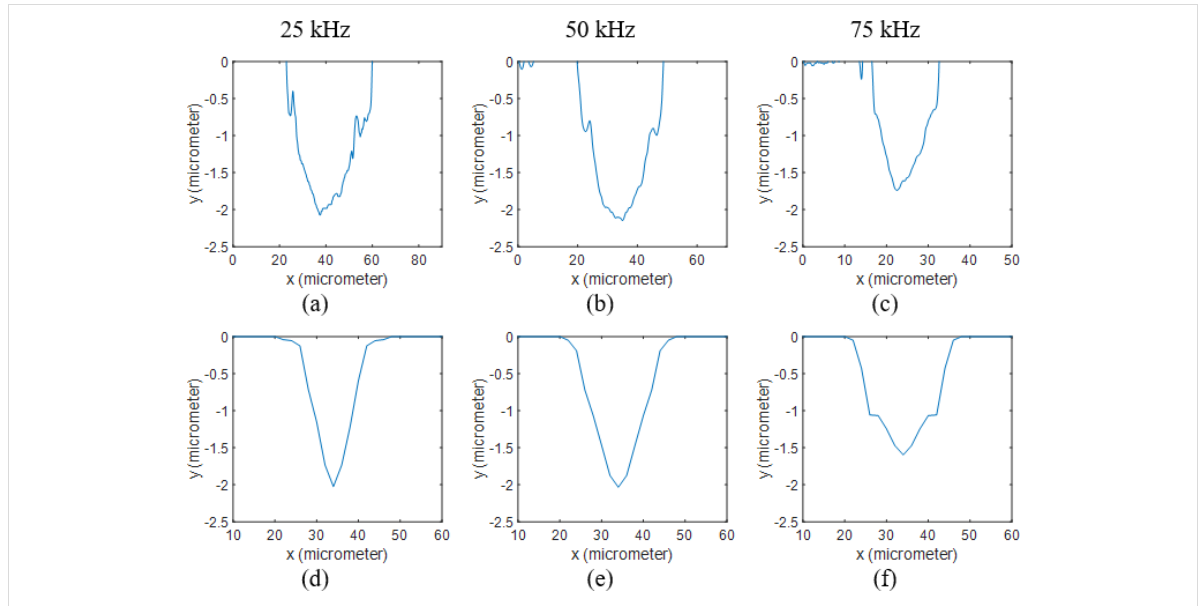
Figure 4: 2D profiles of Al coated Si samples processed at 5 W. Results obtained from measurements when using (a) 25 kHz, (b) 50 kHz and (c) 75 kHz are compared to the ones calculated through the numerical model at (d) 25 kHz, (e) 50 kHz and (f) 75 kHz.